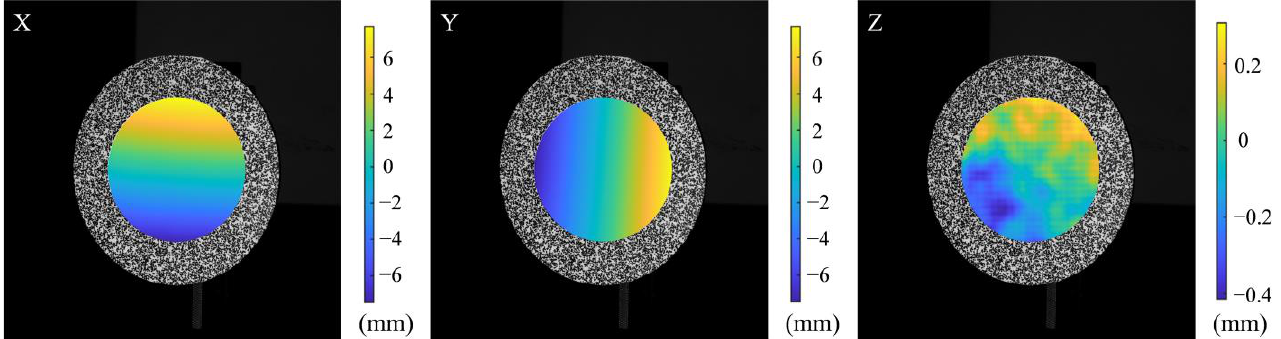
Figure 7. Full-field displacement in the X , Y and Z directions.